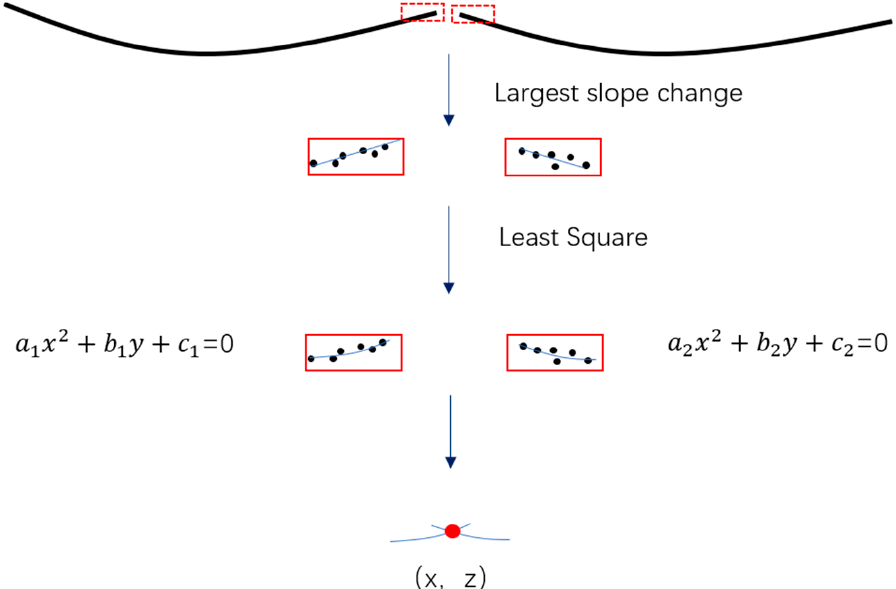
Figure 10. Powerline connection finding based on slope change. Red regions represents the adjacent segmentations that have the largest variation of a single powerline, and (x,z) is the pylon–powerline connection.